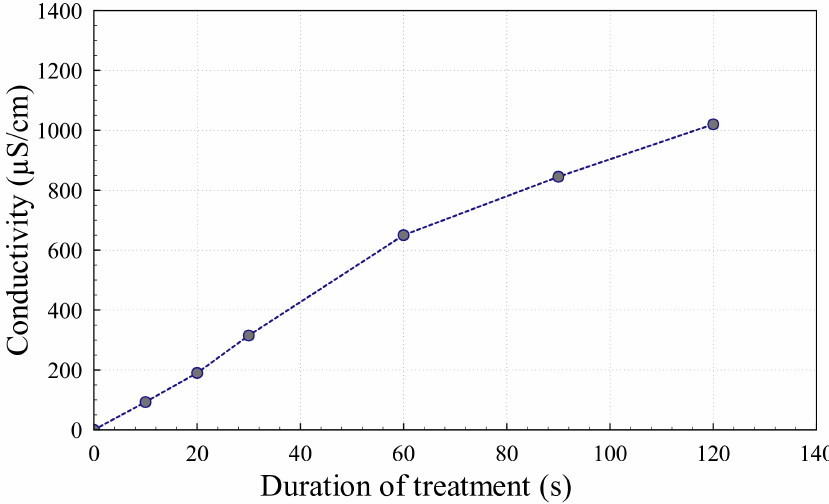
Figure 3. Conductivity of deionized water (DI) water as a function of the duration of plasma treatment.